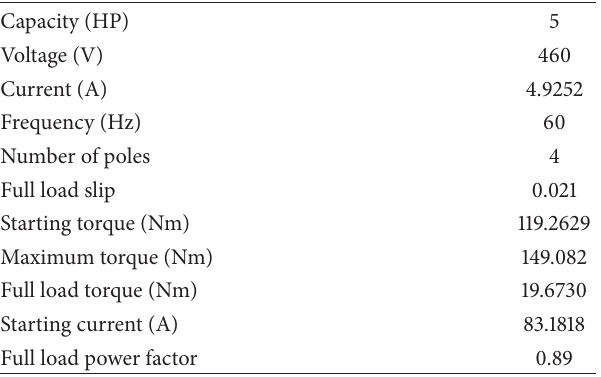
Table 1: Original data of the test motor.